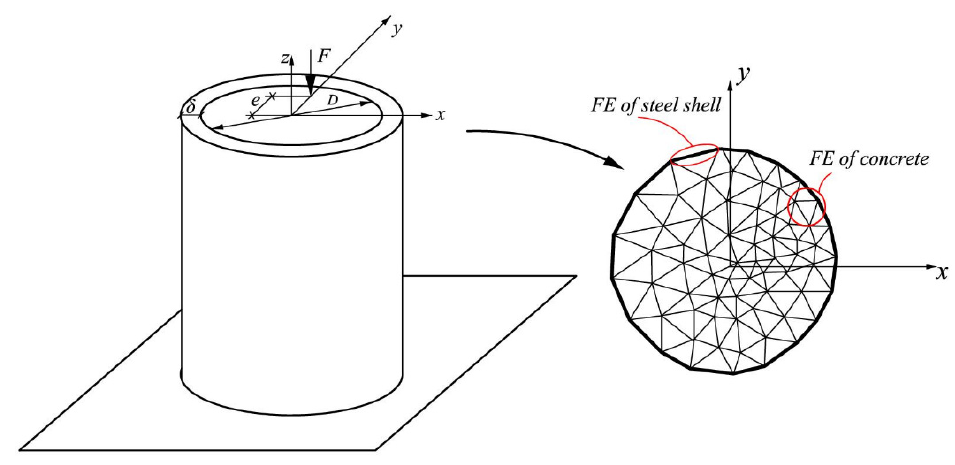
Figure 1. Calculation scheme. Plane triangular finite elements have 2 degrees of freedom at each node